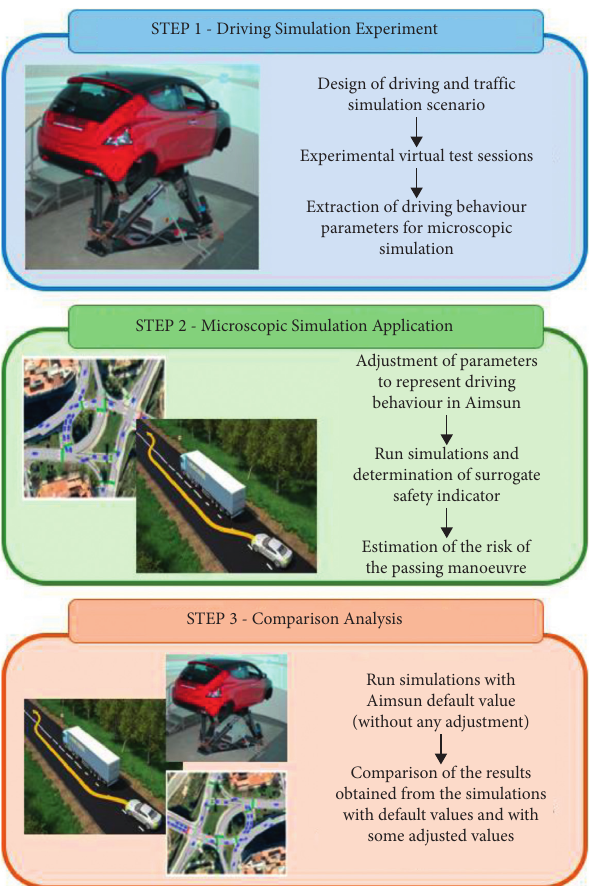
Figure 1: The overall framework of the proposed methodological